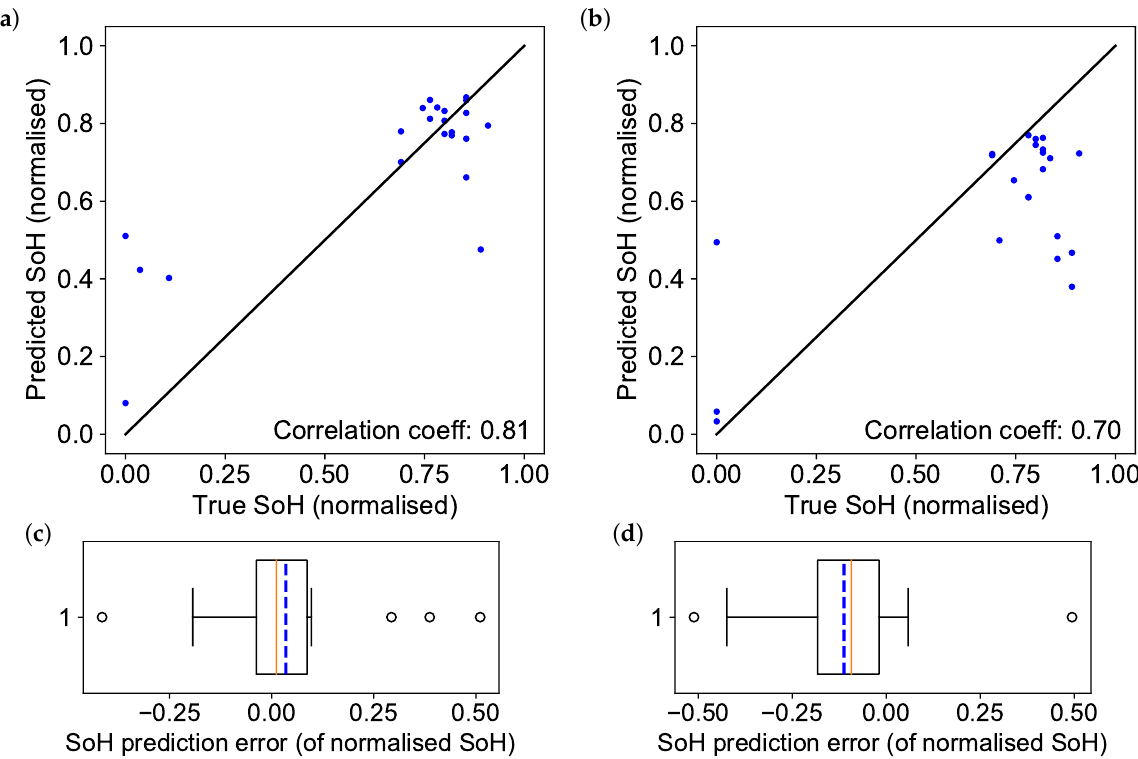
Figure 6. Distribution of predicted vs. ground truth state of health values over a single cross-validation trial shown as scatter ( a , b ) and box plots of the model errors ( c , d ) for the baseline ANN (left) and CNN (right) models. The SoH values (range 77–85%) are normalised to 0–1 for clarity. Each point in ( a , b ) represents a prediction of the CNN and ANN respectively versus the corresponding true SoH, with the diagonal line showing the case of equal prediction and ground truth, i.e. zero prediction error. The solid red and dotted blue lines in ( c , d ) denote median and mean prediction error